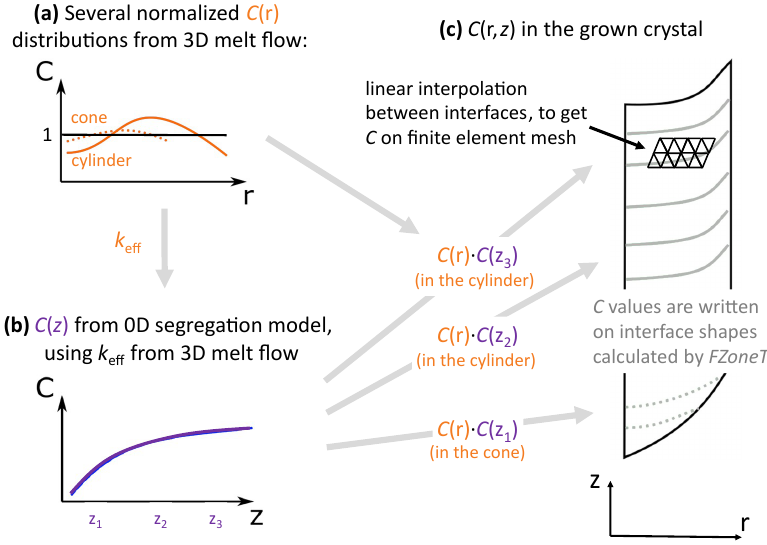
Figure 4. The scheme of species concentration interpolation from OpenFOAM melt flow simulations of the cone stage and cylinder stage ( a ) and 0D-segregation simulations ( b ) on the grown crystal mesh ( c